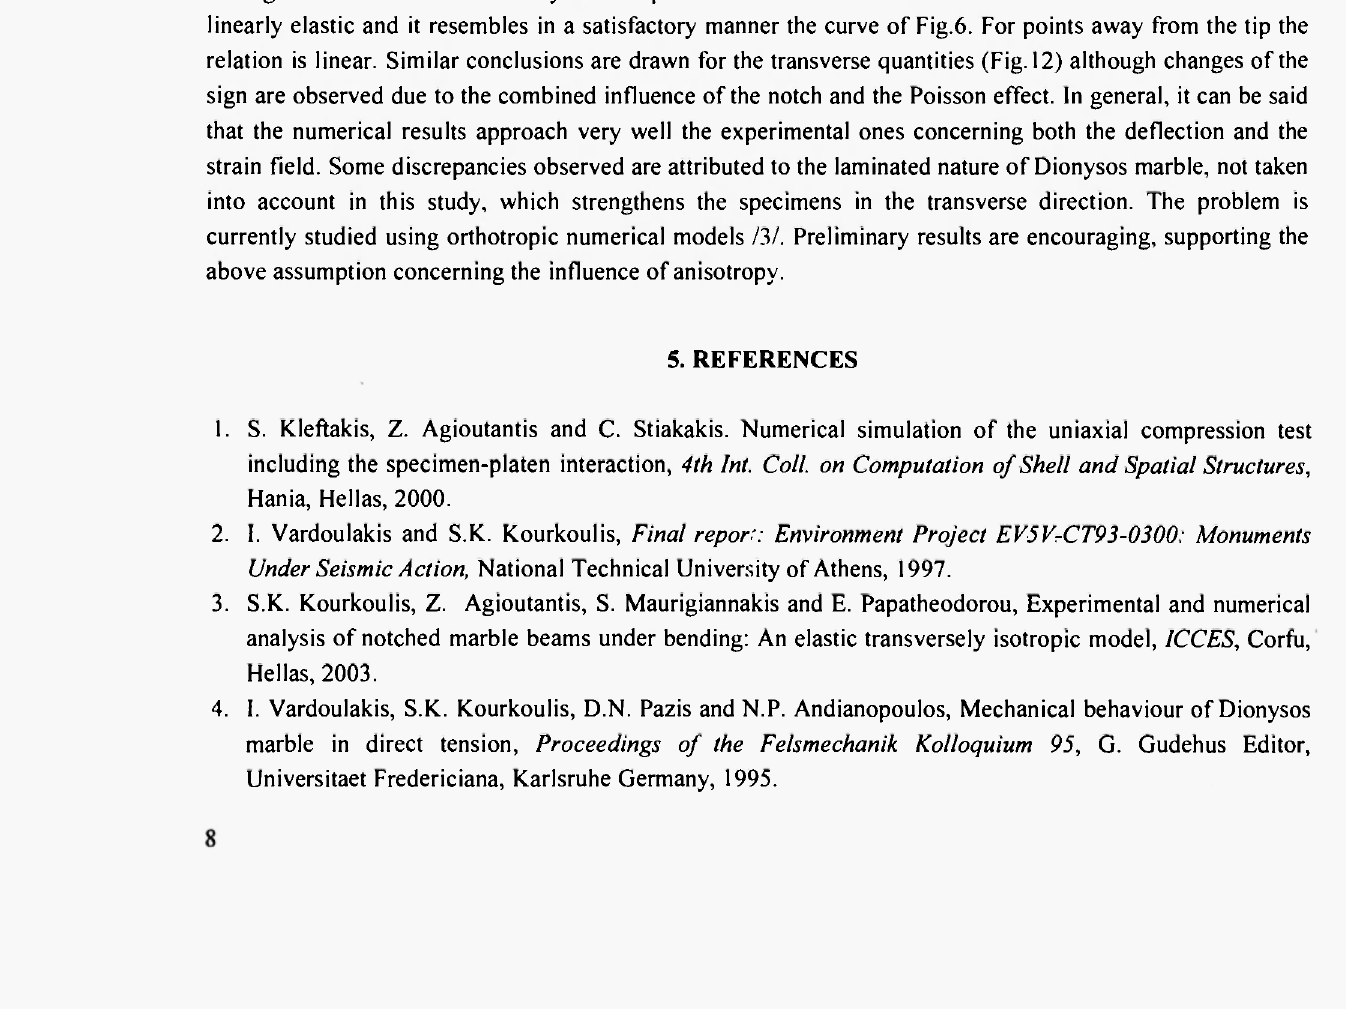
Fig. 12: The transverse stress vs. the transverse strain at various points ahead of the notch